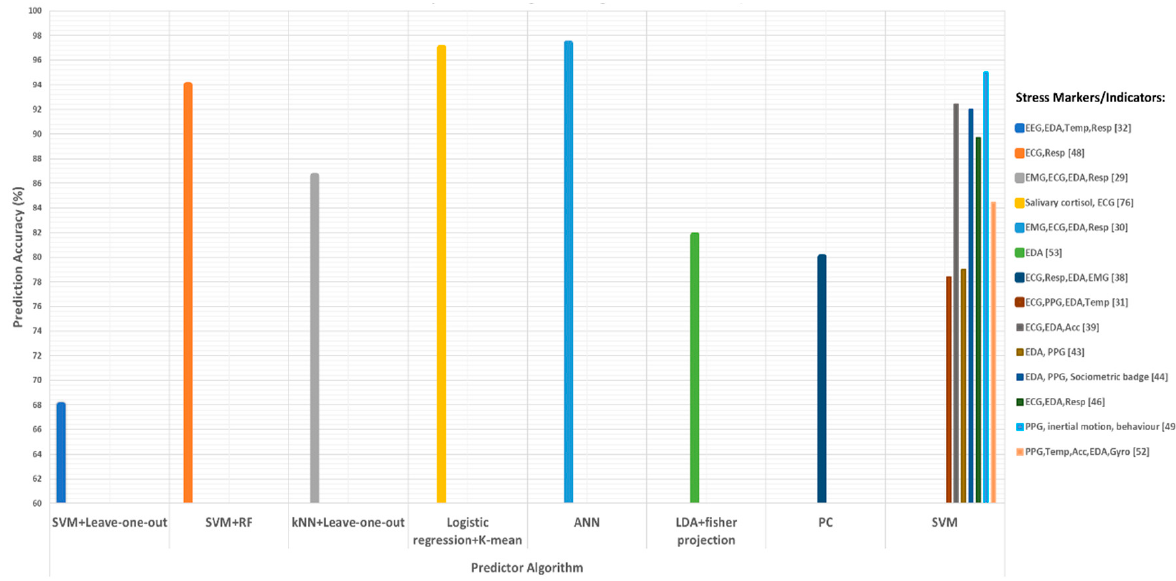
Figure 3. Reported prediction accuracies of various prediction algorithms using different stress indicators/markers. In the figure, SVM is support vector machine, RF is random forest, kNN is k-nearest neighbors, ANN is artificial neural network, LDA is linear discriminator analysis, and PC is principal component analysis. Table 3. Biophysiological parameters (sorted year-wise).